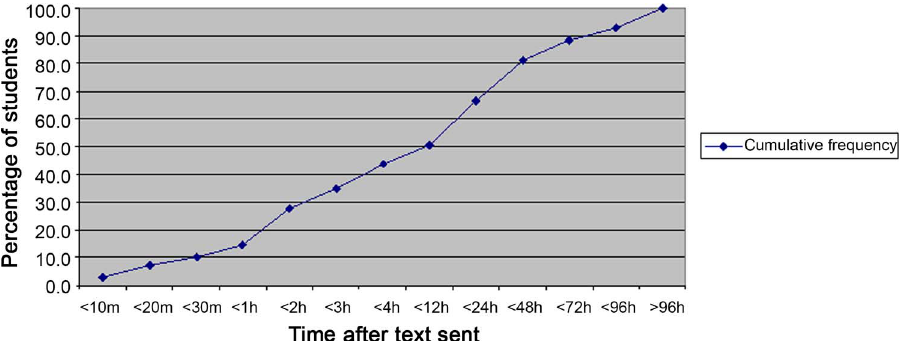
Figure 7. The relationship between the time the text messages were sent out and students’ arrival in the virtual learning environments